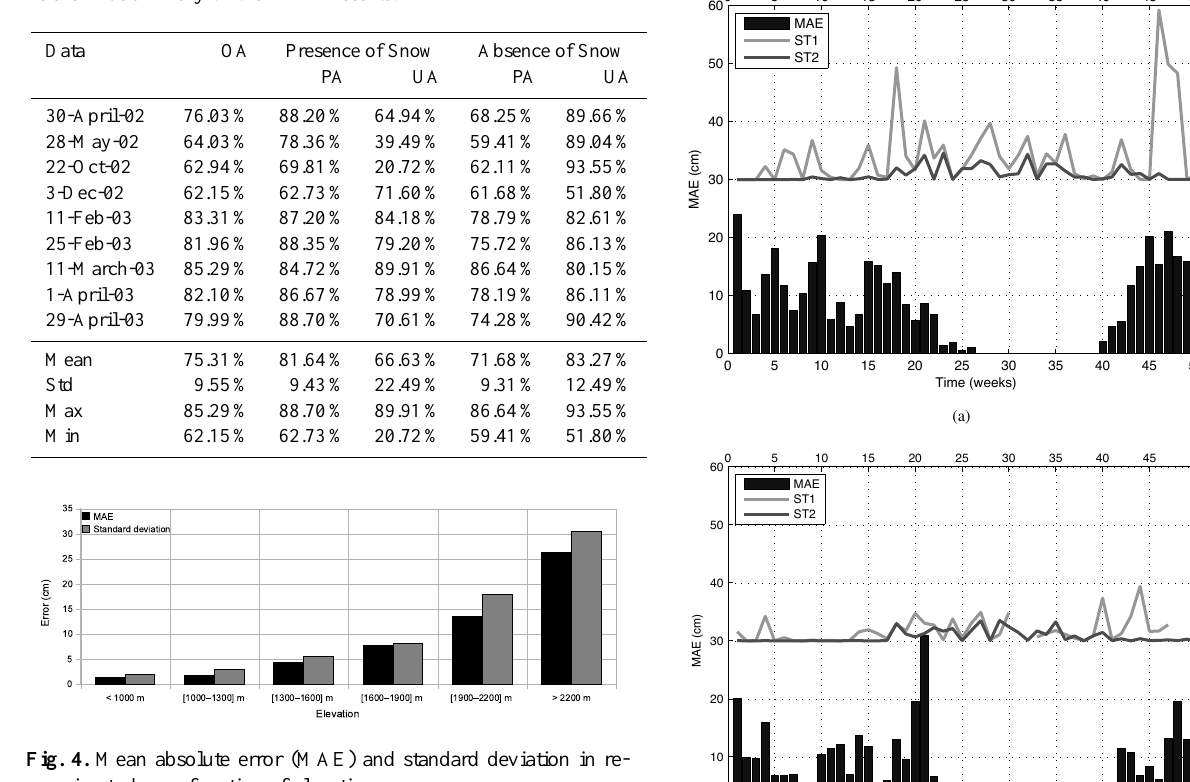
Table 11. Summary of the RBFN results.